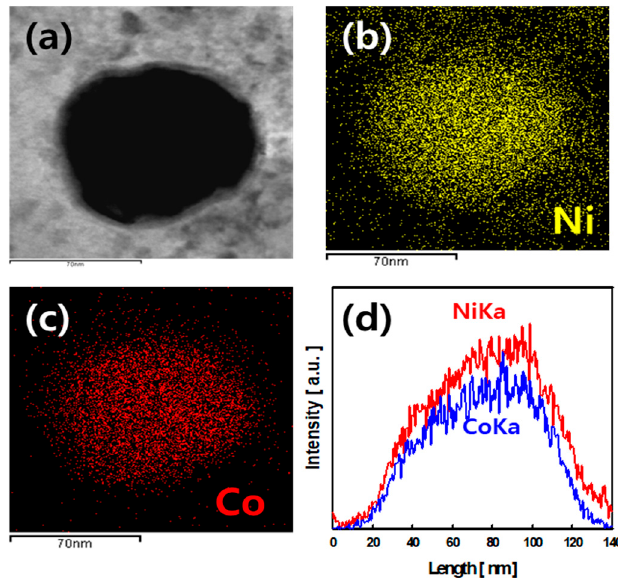
Figure 3. Bimetallic particle analysis of NCOCC-55 using FE-TEM and EDS. FE-TEM real image ( a ), Ni elemental mapping ( b ), Co elemental mapping ( c ) and line scanning profile ( d ).